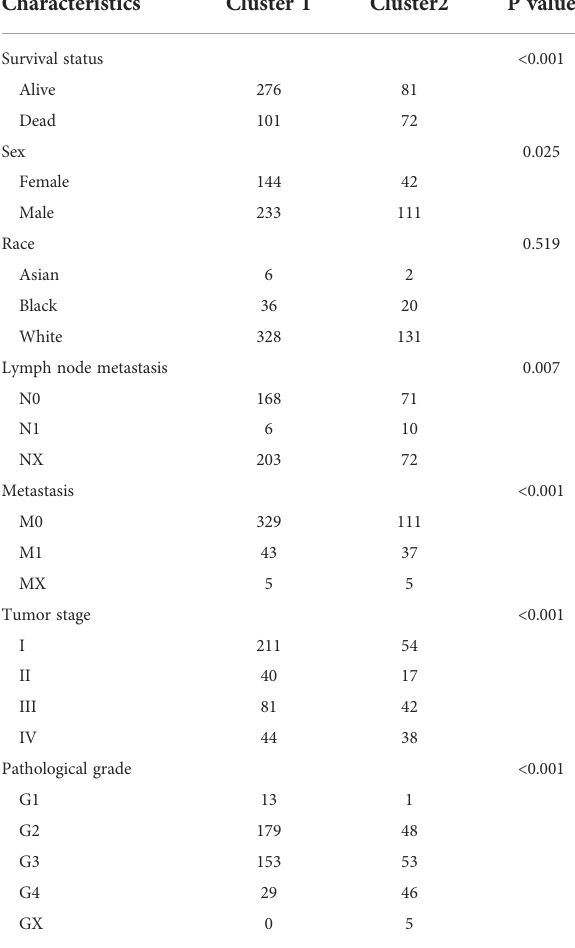
TABLE 1 Clinicopathological feathers between the two clusters.